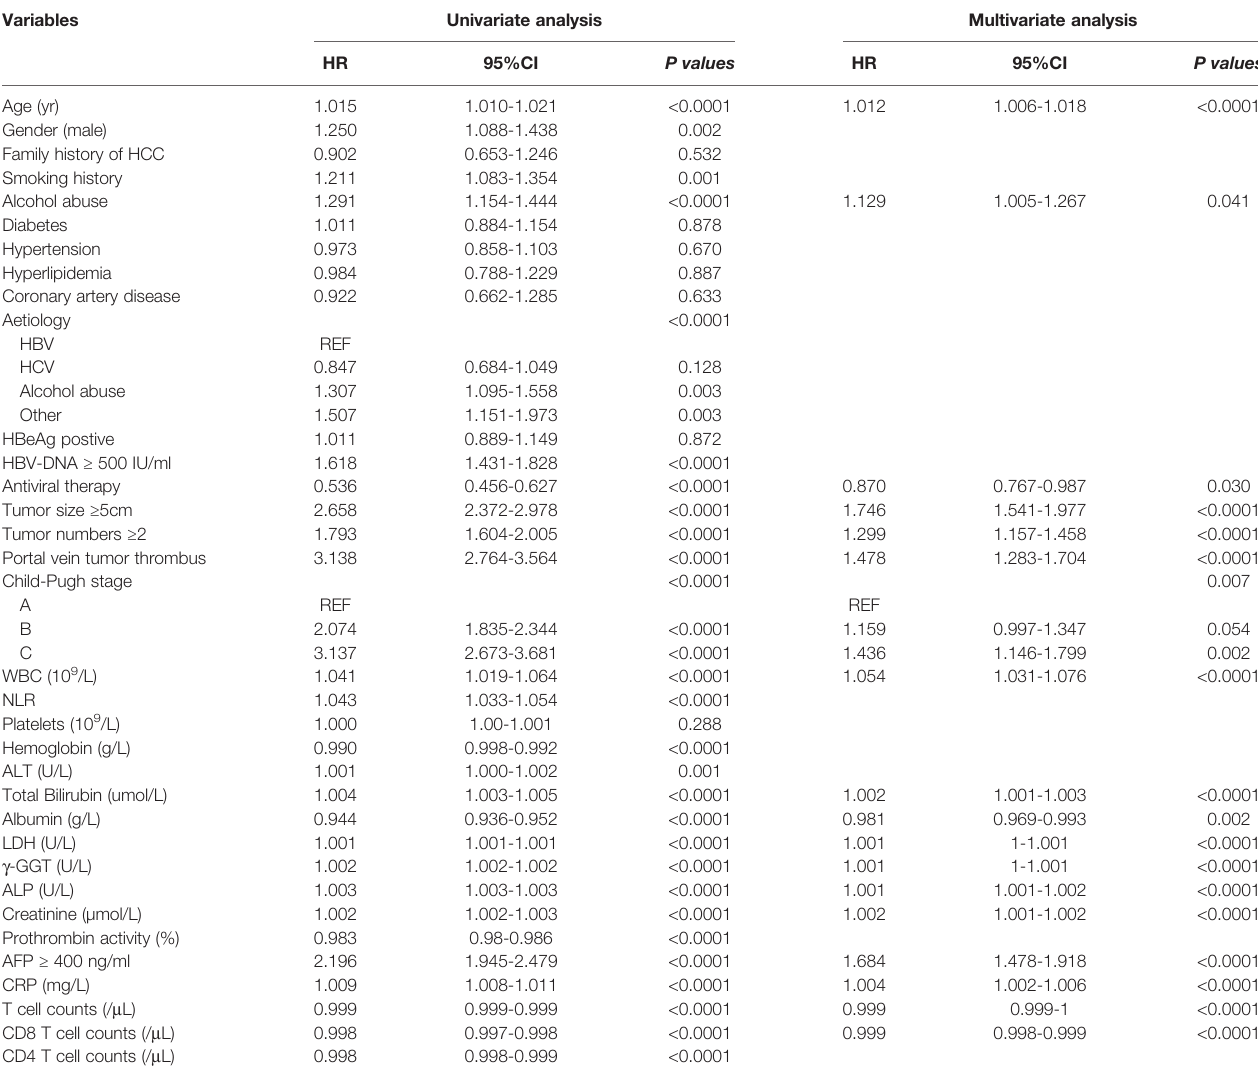
TABLE 2 | Factors associated with overall survival of patients with HCC.